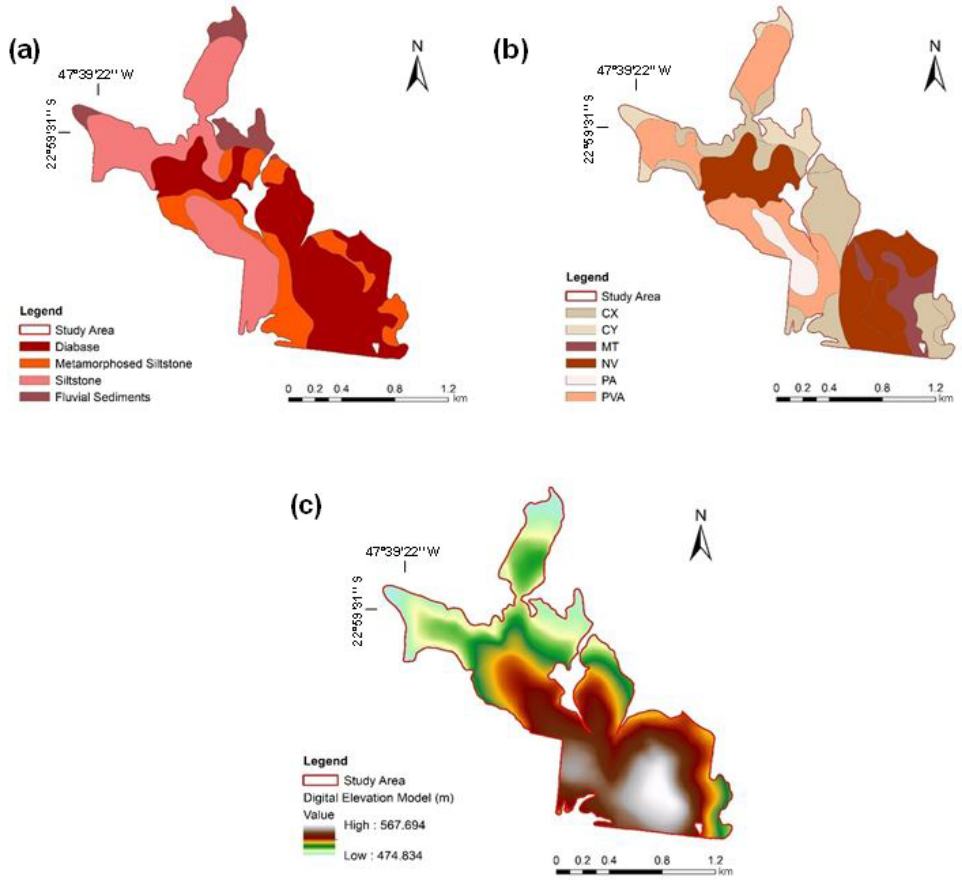
Figure 2. (a) Geological compartments of the landscape. (b) Soil classes – CX: Haplic Cambisols, CY: Fluvic Cambisols, MT: Luvic Phaozem, NV: Rhodic Nitisol: PA: Xanthic Acrisol, PVA: Rhodic Lixisol. The geological and soil class maps were adapted from Bazaglia Filho et al. (2012). (c) Digital elevation